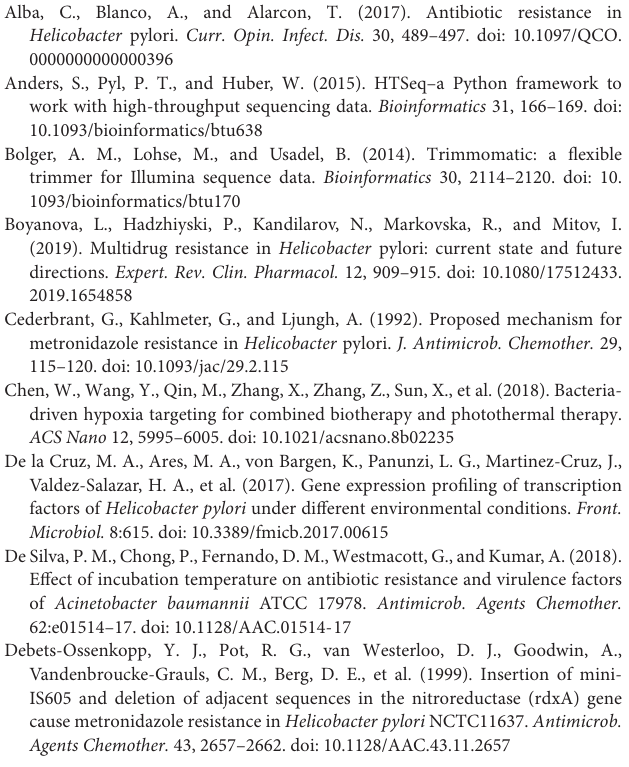
Supplementary Figure 1 | Agarose gel electrophoresis of gene fragments of H. pylori NCTC 11637 amplified by PCR. (A) Lanes 1–6, PCR fragments of gene